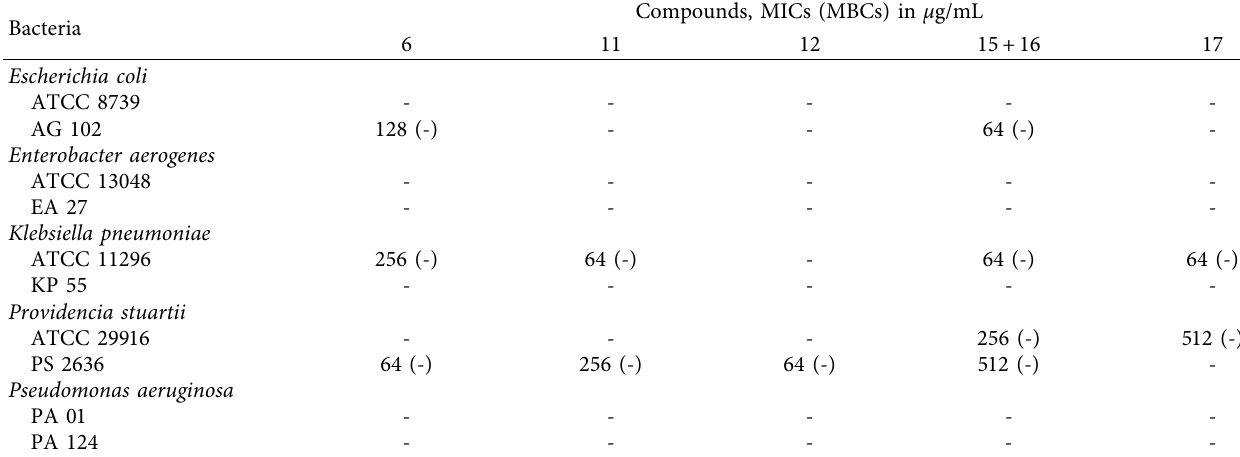
Table 2: Minimum inhibitory concentration (MIC) and minimum bactericidal concentration (MBC) in μ g/mL of isolated compounds of P. glandulosus against selected Gram-negative bacteria. Bacteria